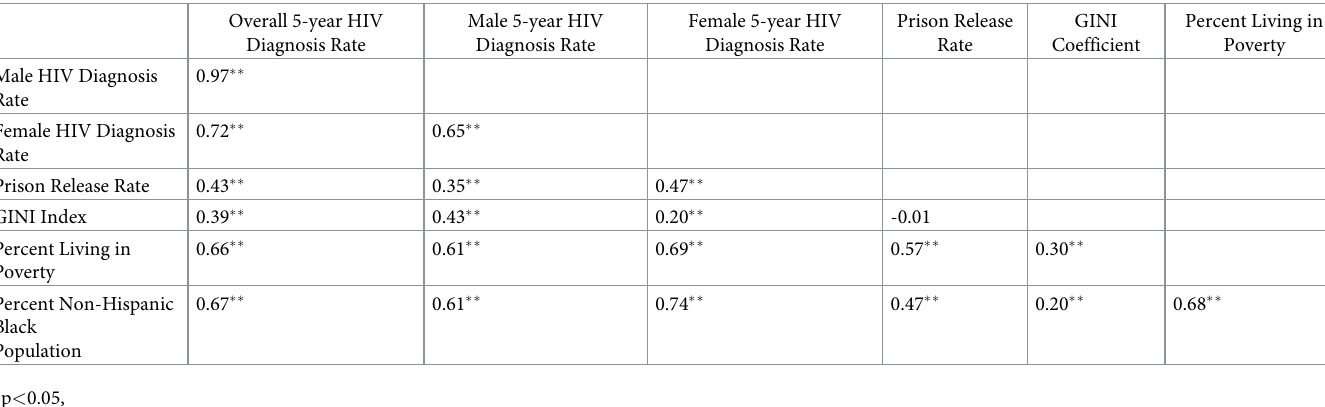
In bivariate analysis (Spearman correlations), overall 5-year HIV diagnosis rate was moder- ately associated with prison release rate (r = 0.43, p < 0.01). Stratifying the data by gender, we found that prison release rate was moderately associated with female (r = 0.47, p < 0.01) and less strongly associated with male (r = 0.35, p < 0.01) HIV diagnosis rate. Prison release rate was also moderately associated with percent population living in poverty (r = 0.57, p < 0.01) and percent Non-Hispanic Black population (r = 0.47, p < 0.01). (Table 2) Table 2. Spearman correlations among independent covariates and overall, male, and female 5-year HIV diagnoses rates. Overall 5-year HIV Diagnosis